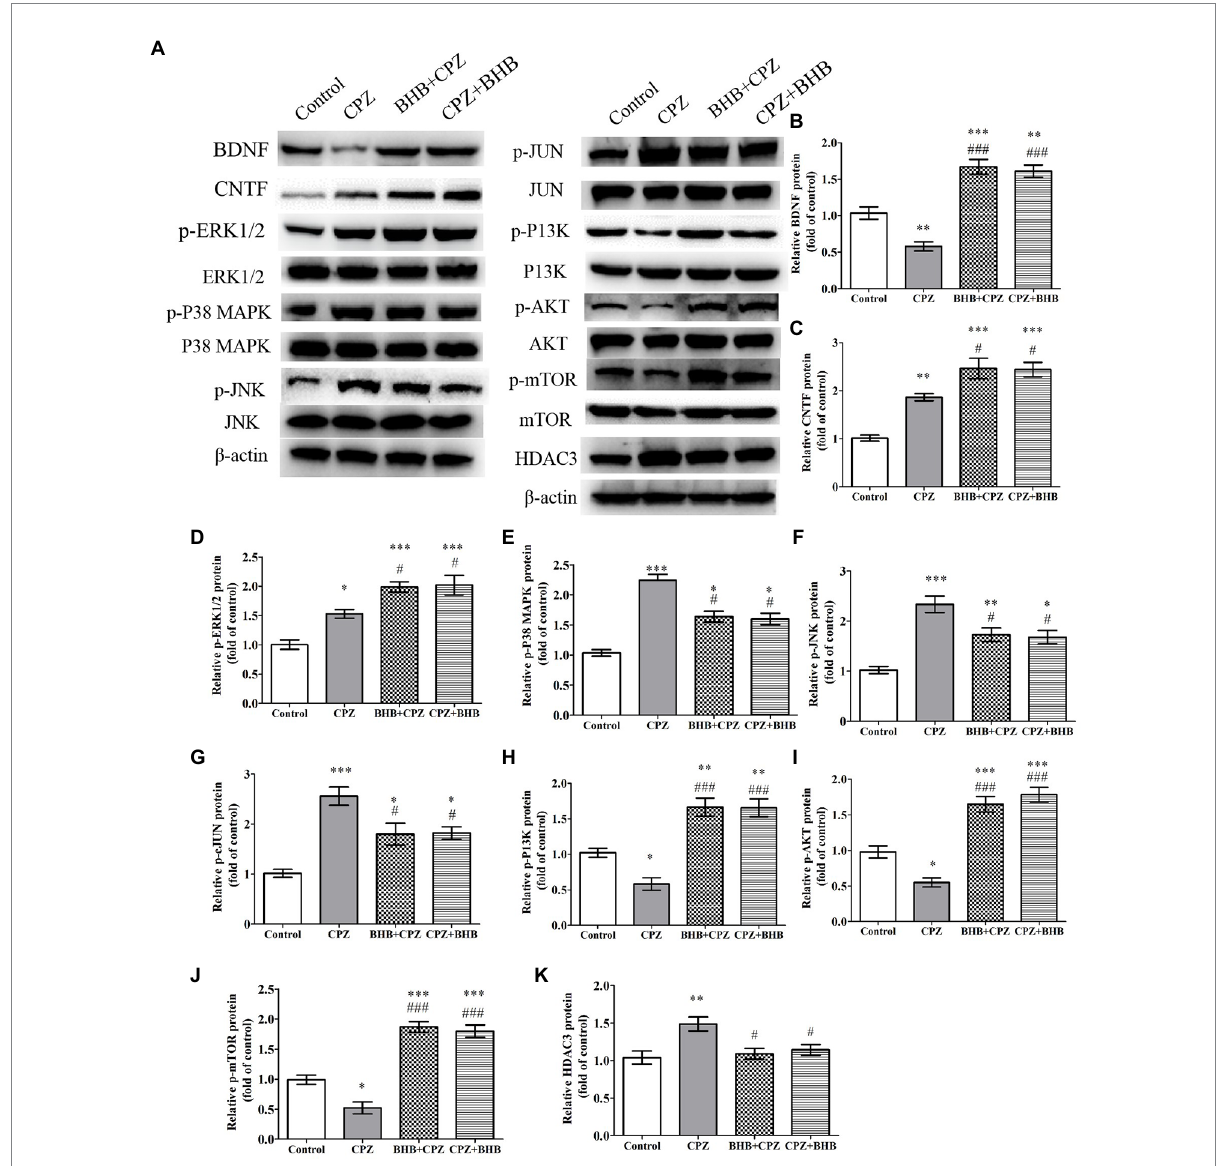
FIGURE 10 The effect of CPZ on the expression of BDNF CNTF and HDAC3, and the phosphorylation state of ERK1/2, p38-MAPK, JNK, c-Jun, PI3K, Akt, mTOR in the corpus callosum of CPZ-fed mice in different groups. (A) Representative images of WBs are shown. WBs were performed to detect the (B) BDNF, (C) CNTF, (D) p-ERK1/2, (E) p-P38-MAPK, (F) p-JNK, (G) p-JUN, (H) p-PI3K, (I) p-PI3K, (J) p-mTOR, and (K) HADC3 protein levels in CPZ-fed mice. β -actin was used as an internal control. Quantification of WB bands was conducted by ImageJ. The data are presented as mean ± SEM. N = 3 per experimental group; experiment repeated two times. * p < 0.05, * p < 0.01, and *** p < 0.001 versus the control group; # p < 0.05 and ### p < 0.001 versus the CPZ